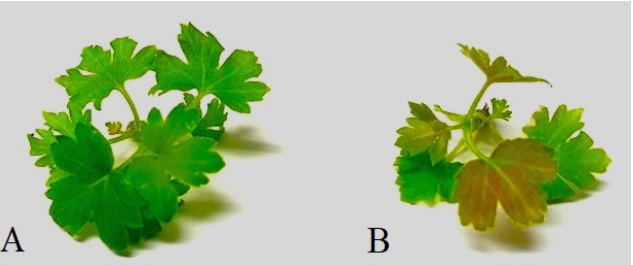
Figure 6. Microshoots of R. aureum after 6 dpi: ( A ) BRV ‐ free mock ‐ inoculated microshoot; ( B ) BRV ‐ infected microshoot.